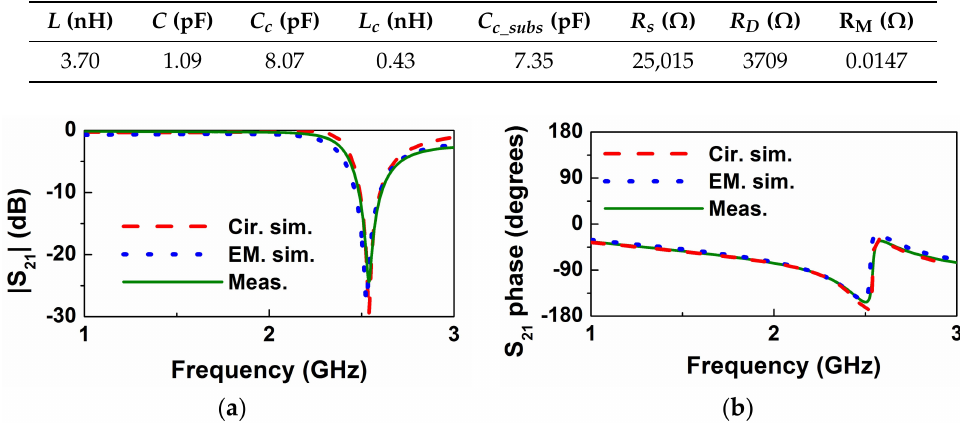
Table 1. Circuit parameters corresponding to the empty sensing structure of Figure 1.